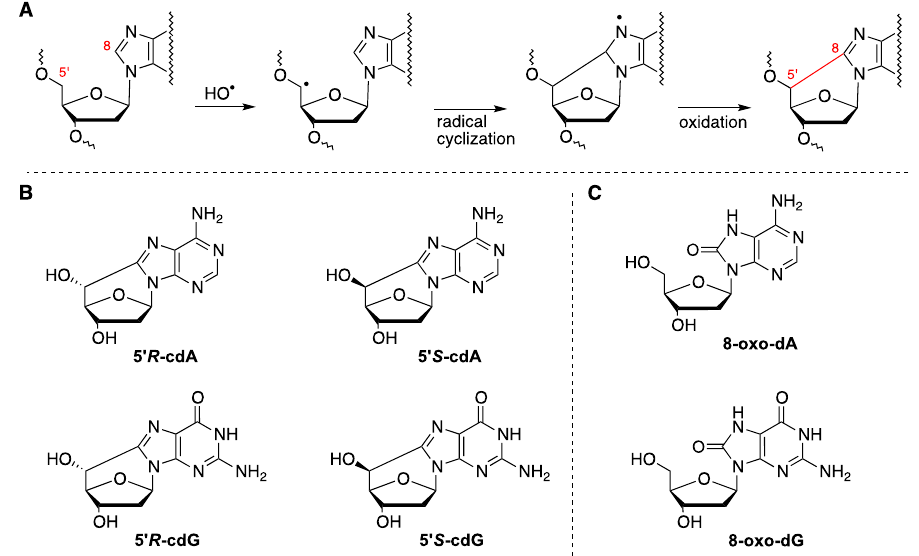
Figure 1. ( A ) purine 2 ′ -deoxynucleoside reacts with hydroxyl radical (HO • ) yielding the purine 5 ′,8 - 5 (cid:48) ,8-cyclo-2 (cid:48) -deoxynucleoside (cPu) via cyclization of C5 (cid:48) radical followed by oxidation; ( B ) cyclo-2 ′ -deoxynucleoside (cPu) via cyclization of C5 ′ radical followed by oxidation; ( B ) structures of 5 ′ ,8-cyclo-2 ′ -deoxyadenosine (cdA) and 5 ′ ,8-cyclo-2 ′ -deoxyguanosine (cdG) in their 5 ′ R and 5 ′ S diastereomeric forms; ( C ) structures of 8-oxo- 2′ -deoxyadenosine (8-oxo-dA) and 8-oxo- 2′ - 5 (cid:48) R and 5 (cid:48) S diastereomeric forms; ( C ) structures of 8-oxo-2 (cid:48) -deoxyadenosine (8-oxo-dA) and deoxyguanosine (8-oxo-dG). 8-oxo-2 (cid:48) -deoxyguanosine